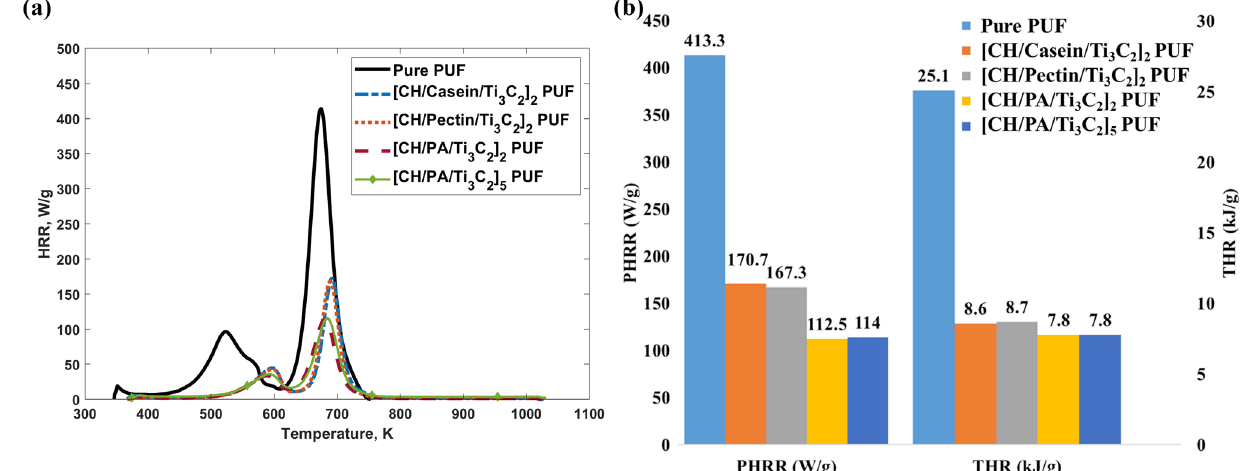
Figure 4. ( a ) HRR curves and ( b ) summarised MCC results for pure and all coated PUFs.